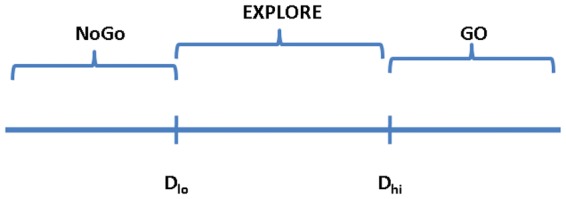
The Go, Explore and NoGo regimes of BG.